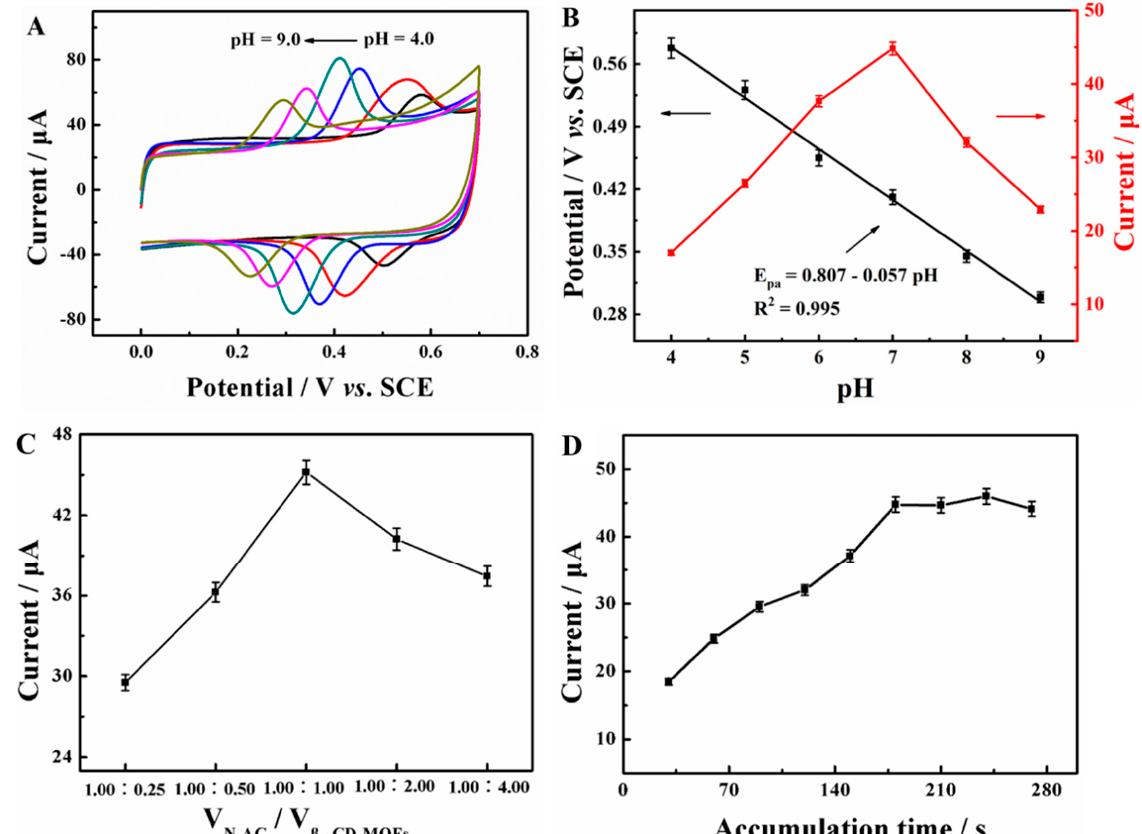
Figure 5. ( A ) CVs of N-SC/ β -CD-MOFs/GCE in PBS with 20.0 μ M AC under different pH (4.0–9.0); ( B ) Relationship between pH value with the anodic peak potentials (black line) and anodic peak currents (red line) toward 20.0 μ M AC; ( C ) Relationship between proportions of N-SC and β -CD- MOFs with the peak currents of 20.0 μ M AC; ( D ) Relationship between accumulation time with the peak currents of 20.0 μ M AC.